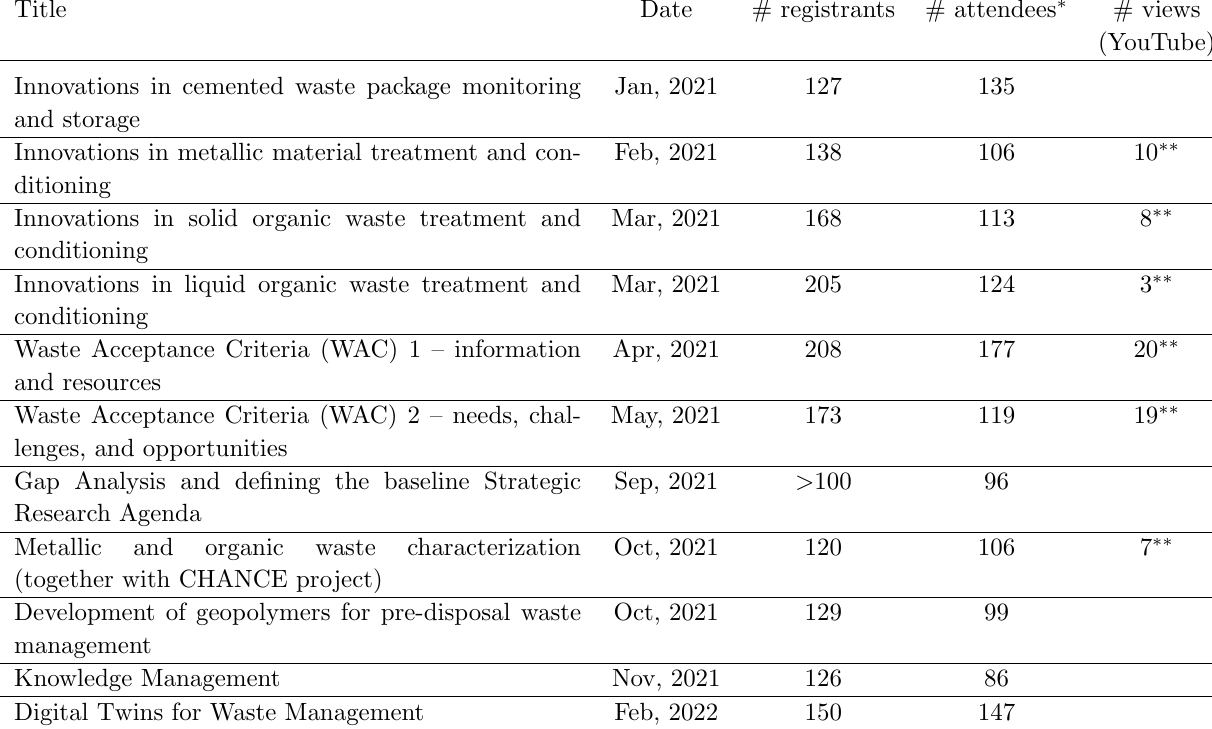
Table 2. Overview of webinars hosted by the PREDIS EU